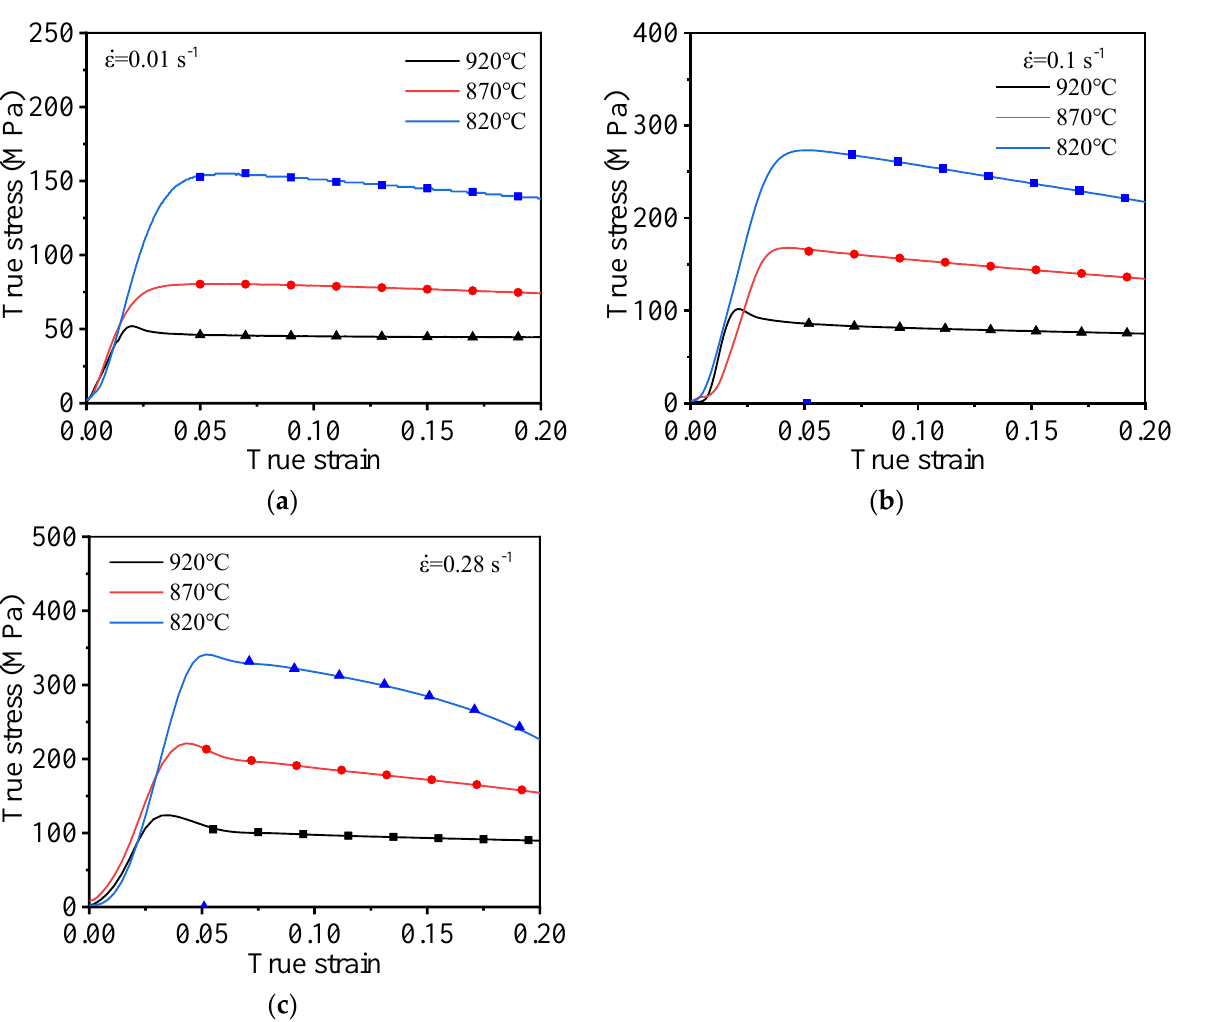
Figure 13. Experimental and predicted values at different deformation conditions: ( a ) 0.01 s −1 ; ( b ) 0.1 s −1 ; ( c ) 0.28 s −1 .